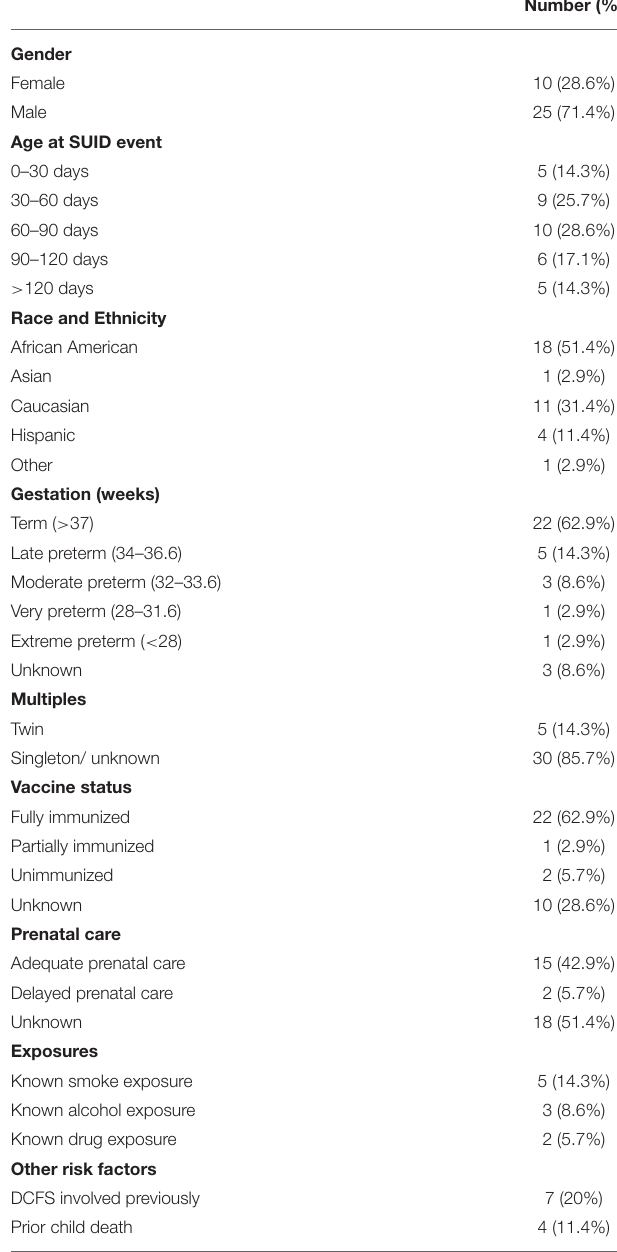
TABLE 1 | Demographics of infants with SUID from 2010–2020 ( n =